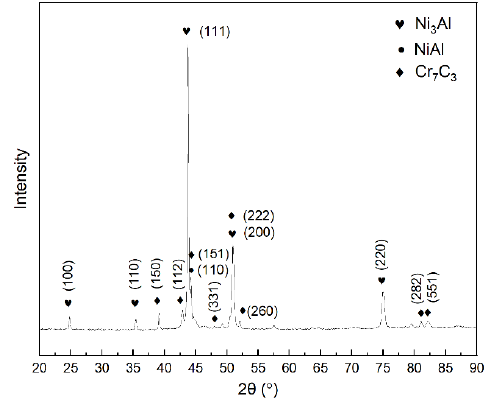
Figure 5. XRD spectrum of the alloyed